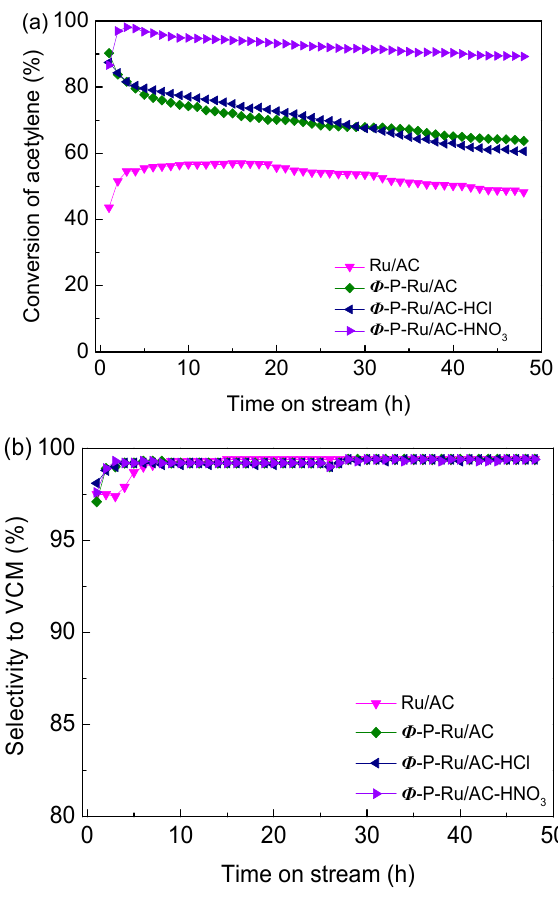
Figure 1. The acetylene conversion ( a ) and selectivity to VCM ( b ) over the synthesized catalysts. Reaction conditions: temperature (T) = 180 °C, GHSV (C 2 H 2 ) = 180 h − 1 and V HCl /V C2H2 = 1.15.